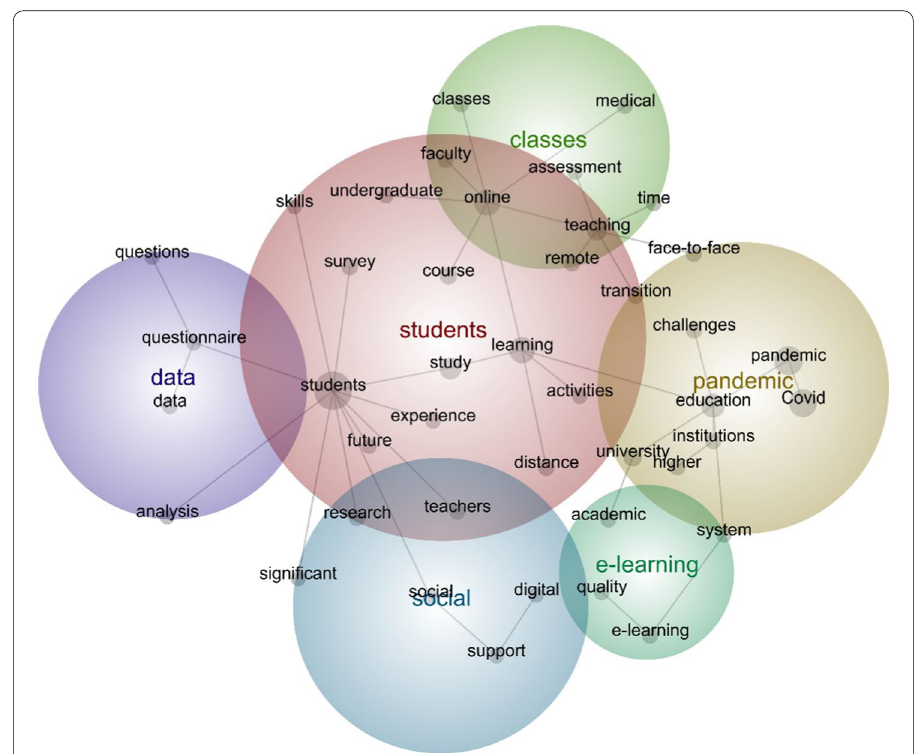
Fig. 5 Concept map of study titles and abstracts ( n